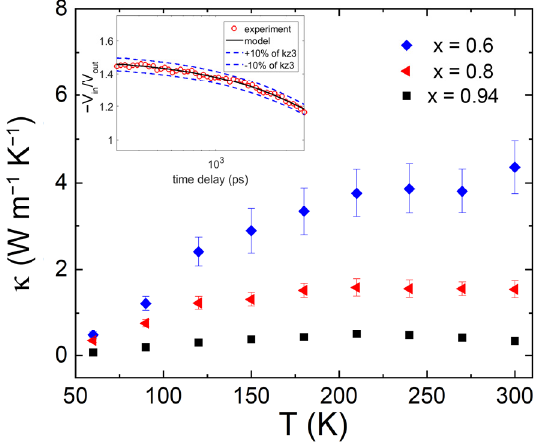
Figure 5. Temperature-dependent out-of-plane thermal conductivity of single (CuCr 2 Se 4 ) 1 − x (CuCrSe 2 ) x (x = 0.94, 0.8, 0.6) crystals measured by the TDTR method. Inset is − V in /V out signal of (CuCr 2 Se 4 ) 0.06 (CuCrSe 2 ) 0.94 sample measured by the TDTR method at room temperature and fitted with a theoretical model to extract thermal conductivity.